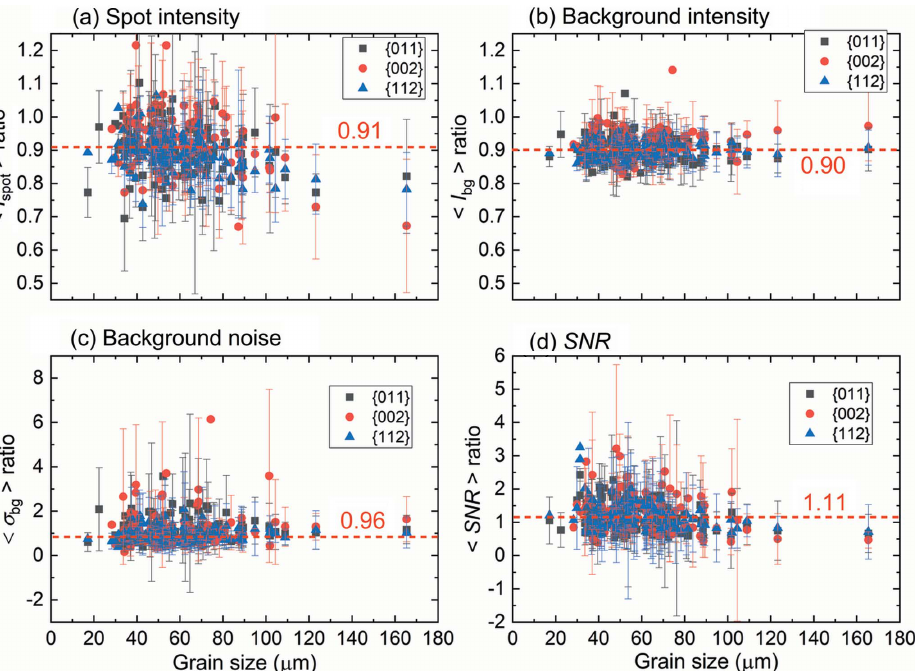
Figure 10 Ratios of ( a ) average spot intensities, ( b ) average local background intensities, ( c ) average local background noise and ( d ) SNRs from Lab-11-18 to Lab- 13-13 datasets as a function of grain size. Dashed lines indicate the median values of all data points in each